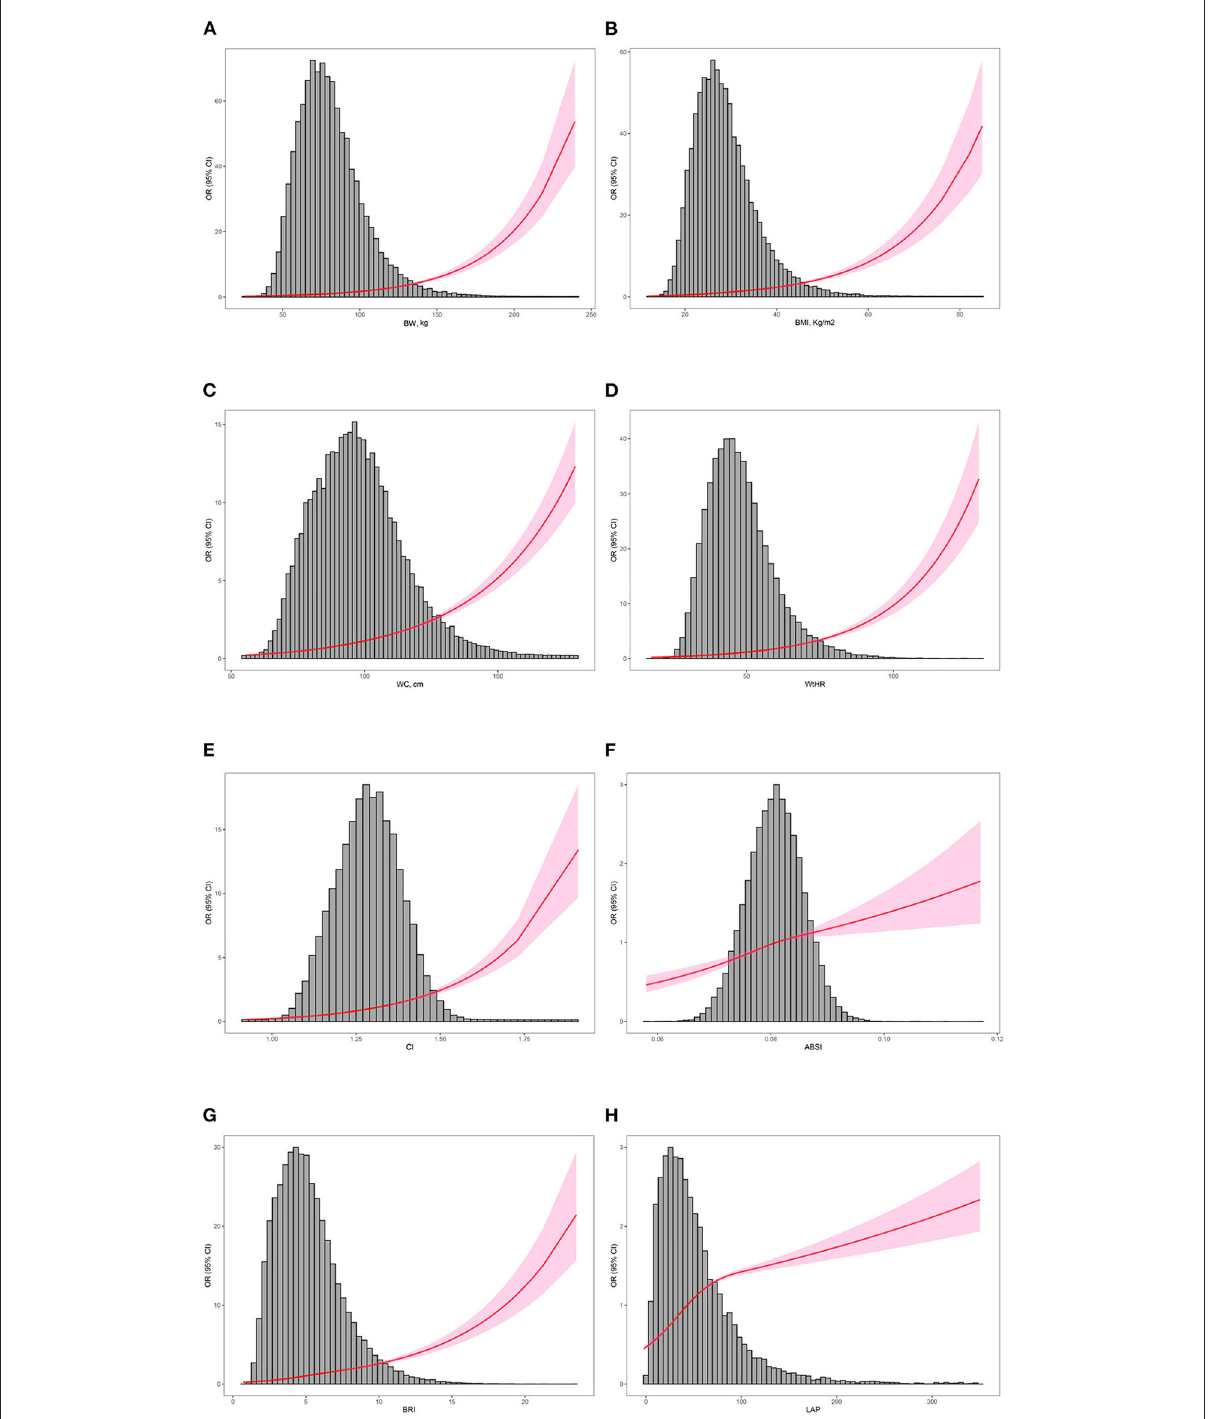
FIGURE2 Distribution of the anthropometric measurements of participants enrolled and restricted cubic splines. The distribution histogram is represented in the background and restricted cubic spline analyses were adjusted for age, sex, race/ethnicity, education, smoking, drinking, diabetes, and eGFR. (A) Association between BW and the risk of hypertension; (B) association between BMI and the risk of hypertension; (C) association between WC and the risk of hypertension; (D) association between WtHR and the risk of hypertension; (E) association between CI and the risk of hypertension; (F) association between ABSI and the risk of hypertension; (G) association between BRI and the risk of hypertension; (H) association between LAP and the risk of hypertension. BW, body weight; BMI, body mass index; WC, waist circumference; WtHR, waist-to-height ratio; CI, conicity index; ABSI, a body shape index; BRI, body round index; LAP, lipid accumulation